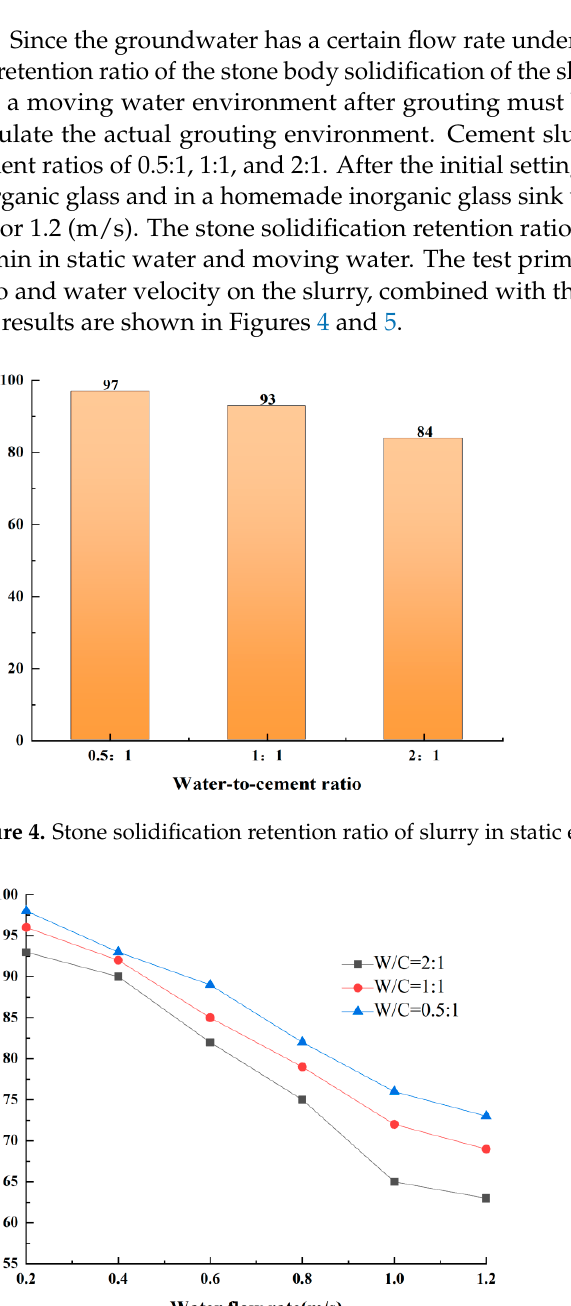
Figure 3. Compressive strength of the solidified slurry stone body.